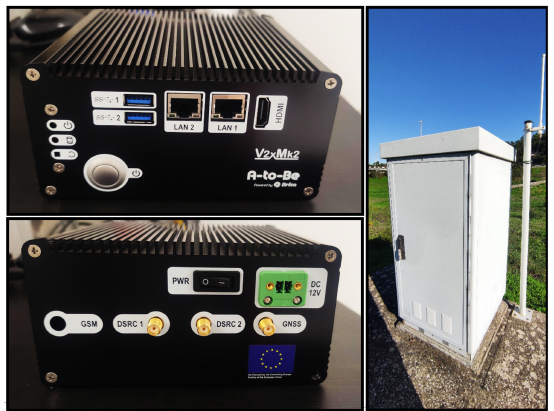
Figure 2. A deployed RSU. It is pictured: the front of the RSU ( top left ) with frontal power switch and USB, Ethernet and HDMI ports; the back of the RSU ( bottom left ) with back power switch, power socket and GSM/LTE, DSRC (ITS-G5) and GNSS antenna connectors; and the housing of the RSU adjacent to a motorway ( right